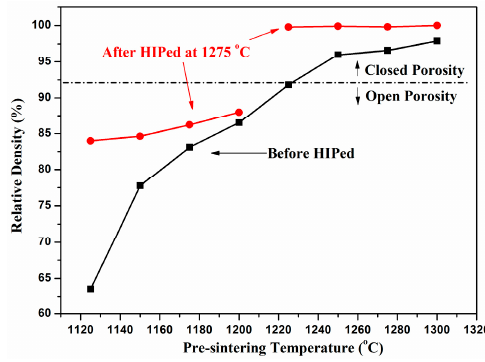
Figure 1. Relative densities of yttria-stabilized tetragonal zirconia polycrystalline (Y-TZP) ceramics containing 3 mol % (3Y-TZP) as a function of pre-sintering temperature (black line and squares), and the corresponding densities after the samples were hot isostatic pressing (HIPed) at 1275 °C (red line and circles).